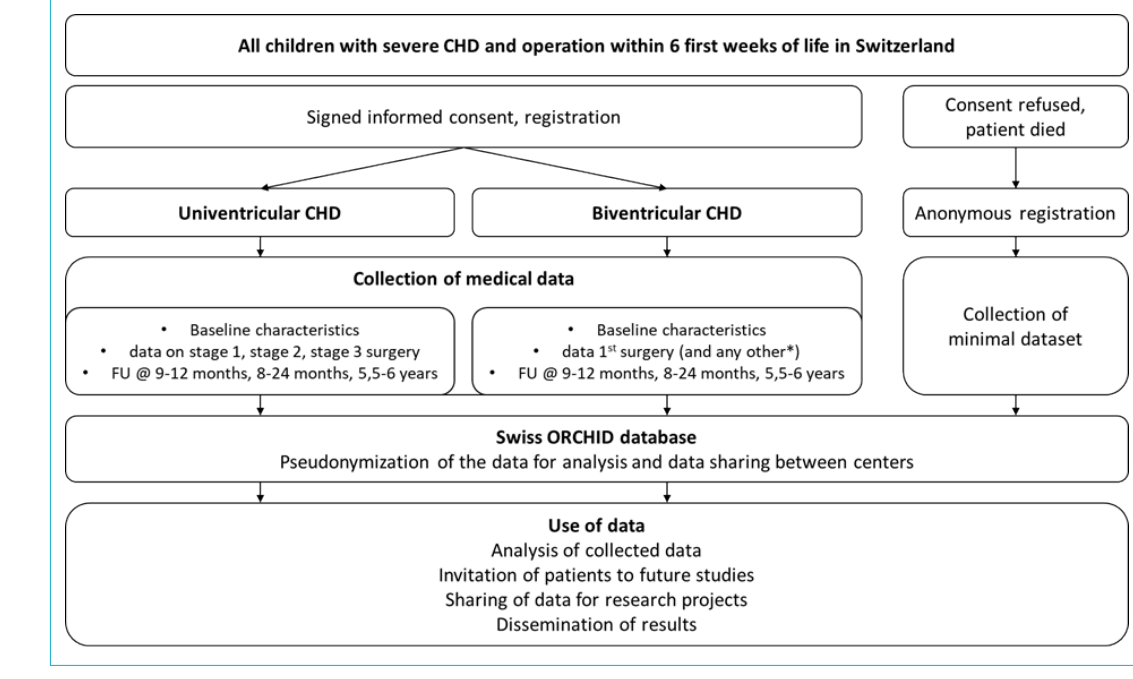
Figure 2: Schematic chart of patient recruitment, data collection, and use of data of the Swiss ORCHID. Stage 1: Norwood or Hybride proce- dure, Stage 2: Bidirectional cavopulmonary anastomosis, Stage 3: Total cavopulmonary connection, FU: follow-up, * other consecutive surg- eries depending on type of congenital heart disease